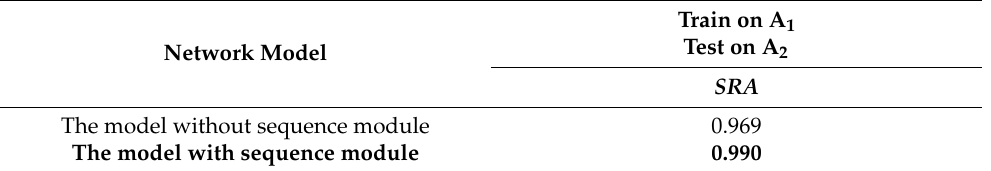
Table 4. SRA on dataset A when applying a sequence module or